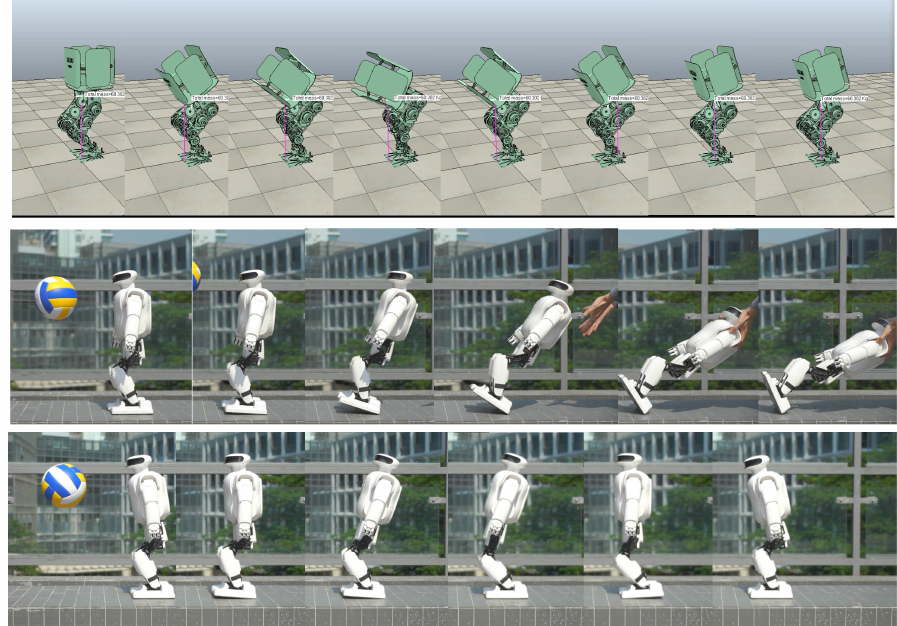
Figure 7. The standing balancing experiment setup. The first row is the robot falling down without momentum compensation control. The second row is the robot recovery from disturbance with momentum compensation